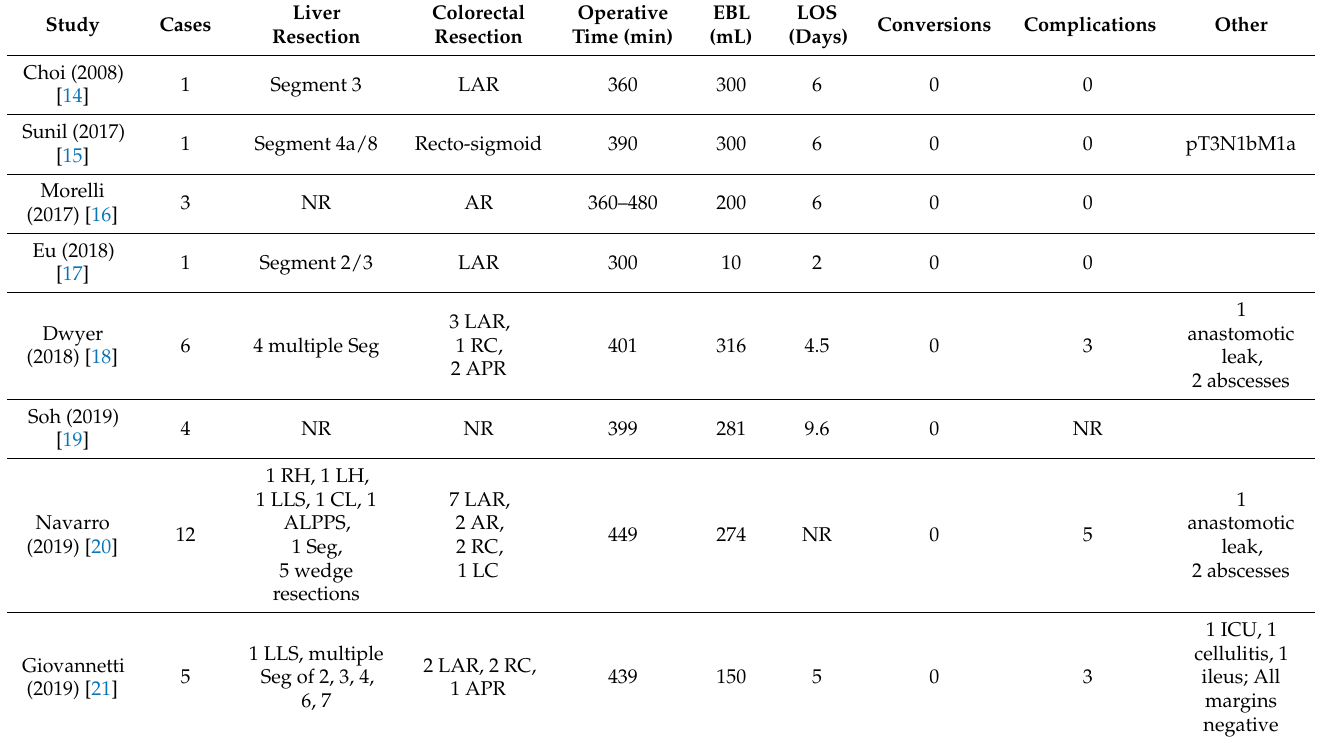
Table 1. Summary of simultaneous robotic hepatic and colorectal resections for synchronous